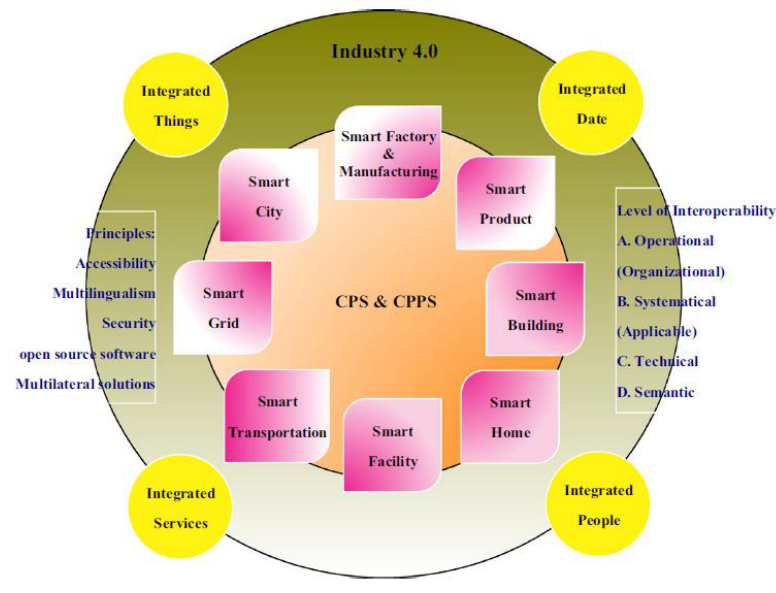
Figure 19. Interoperability framework for I4.0 [139].